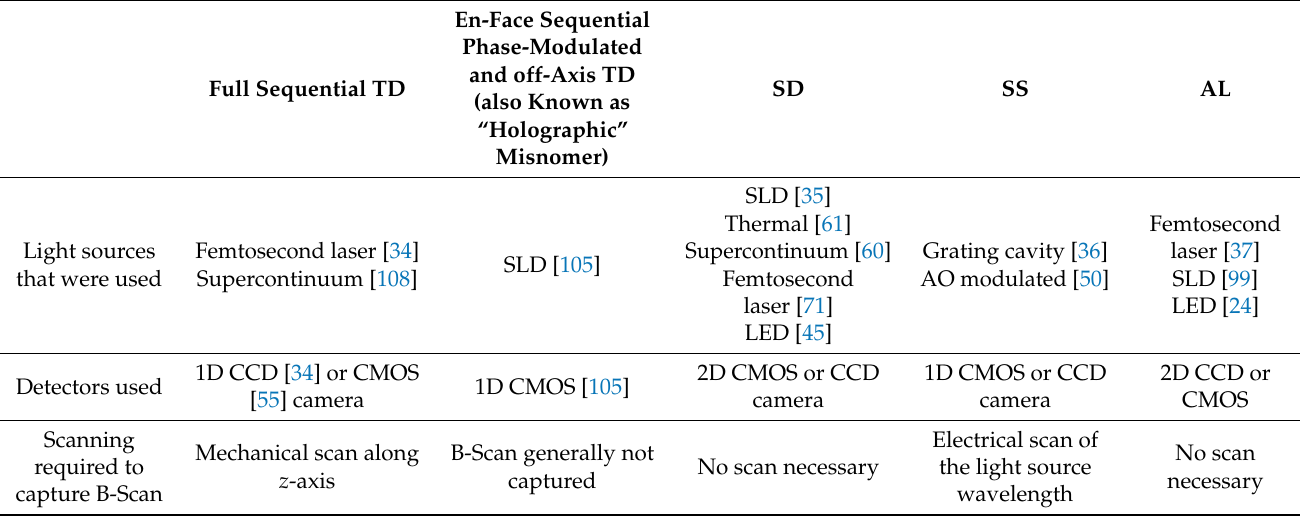
Table 2. Overview of each LF axial